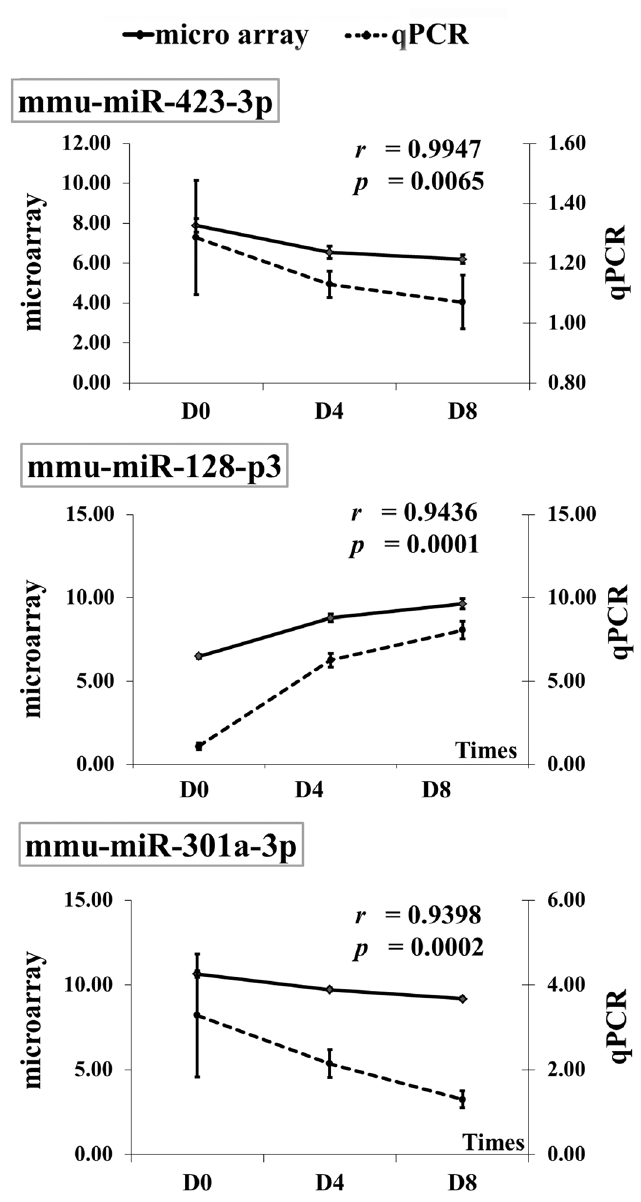
Fig 5. Confirmation of microRNA-microarray results by qPCR. miR-423-3p, miR-128-3p, and miR-301a- 3p were selected for qPCR validation. Mean ± SEM (n = 4) of the log2 transformed microarray result ( –(cid:129)– on primary y-axis) and relative expression (2- ΔΔ Ct) derived from qPCR ( —(cid:129)— secondary y-axis) are overlaid. A correlation coefficient (r) and p-value are